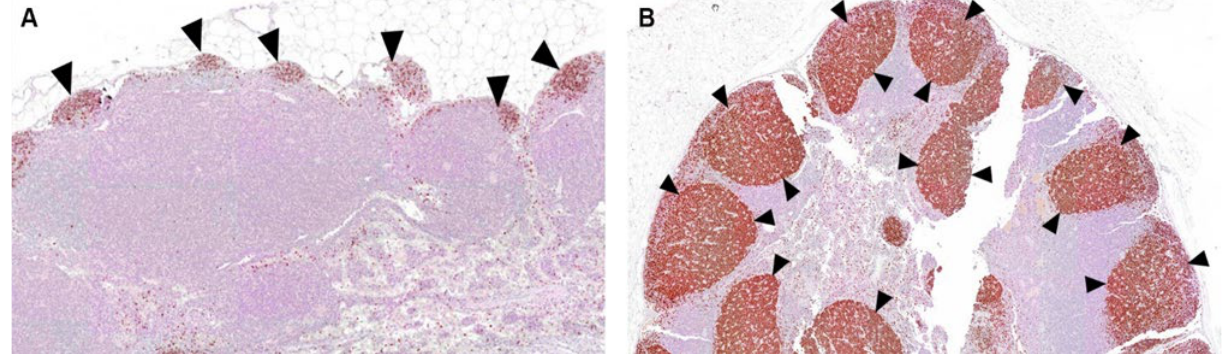
Figure 11. ( A ) The iliac lymph node from an animal injected with the Alhydrogel ® ‘85’, Placebo (Group 1, control item), sacrificed 42 days post first dosing (Recovery phase). Note, arrowheads-no evidence of germinal centers (normal appearance compared with figure b). Staining with antibody for PAX-5 (Biocare’s PAX clone BC/24); and ( B ) the iliac lymph node from an animal injected with C1-RBD Vaccine (Group 2, test item), sacrificed 42 days post first dosing (Recovery phase). The lesions (arrowhead) consist of mild germinal centers increased lymphocytic cellularity (i.e., follicular hyperplasia). Compare with ( A